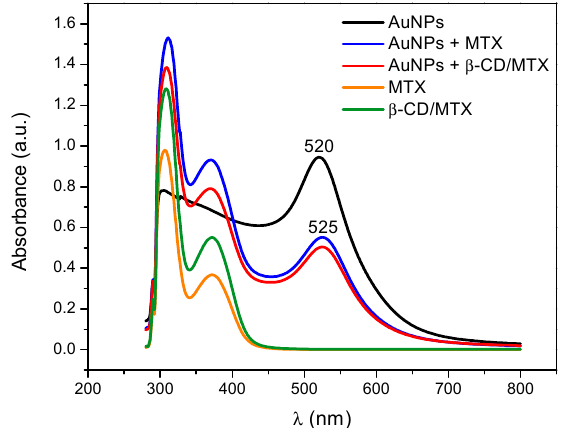
Figure 3. UV-Vis absorption spectra of MTX, inclusion compound (IC) and AuNPs stabilized with citrate ions, MTX molecules, and β -CD/MTX IC.